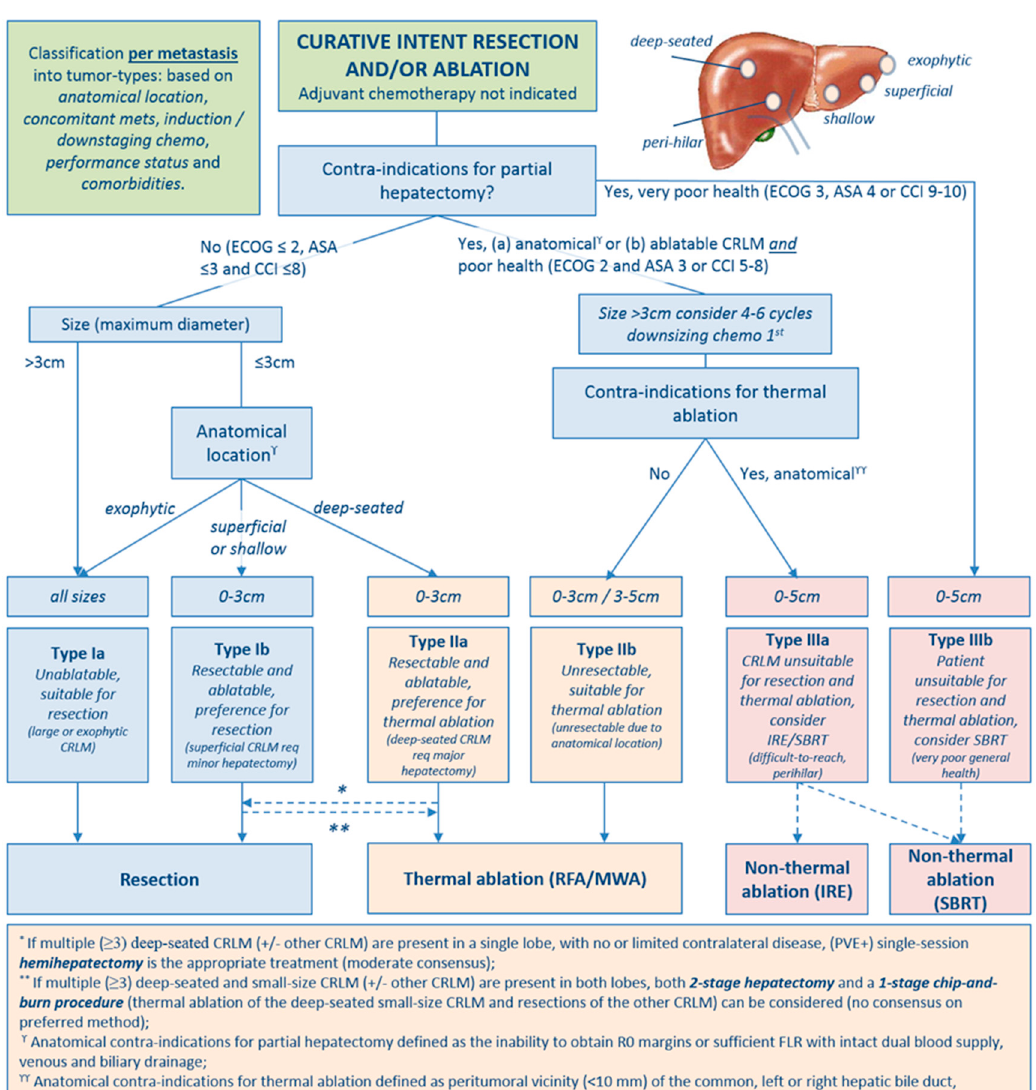
Figure 2. Per-tumor flowchart.